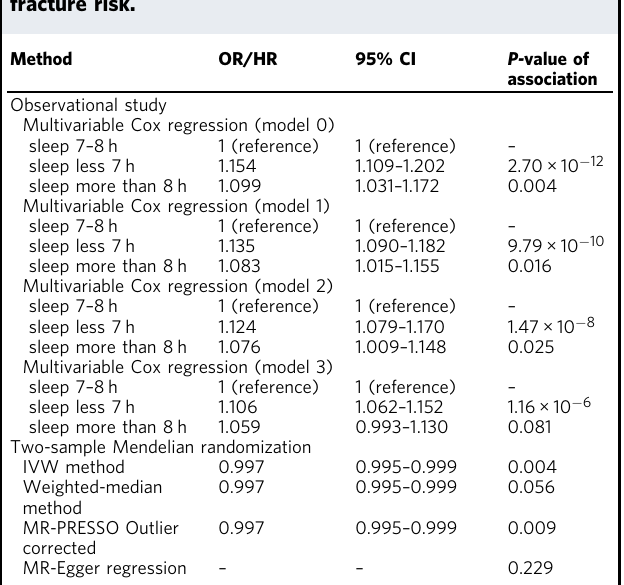
Table 1 Observational and Mendelian randomization analyses for the relationships of sleep duration with fracture risk.